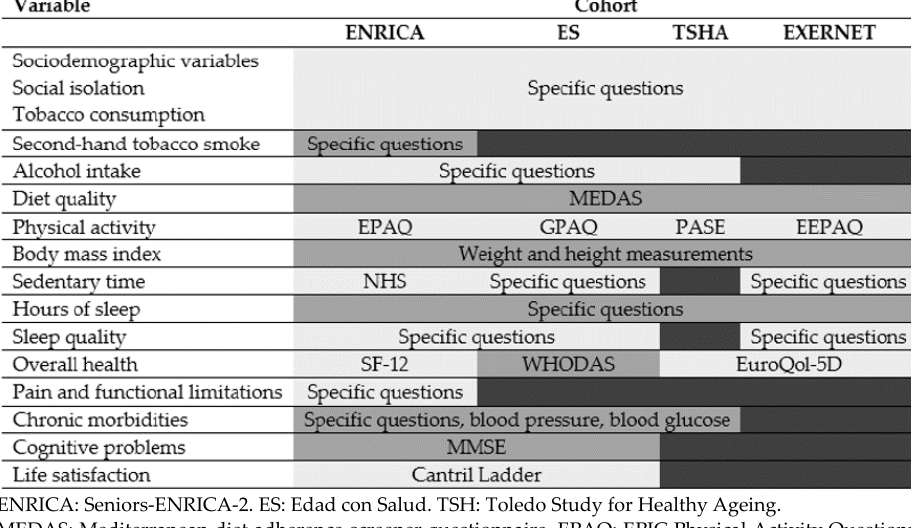
Figure 1. Baseline information collected in the study cohorts.